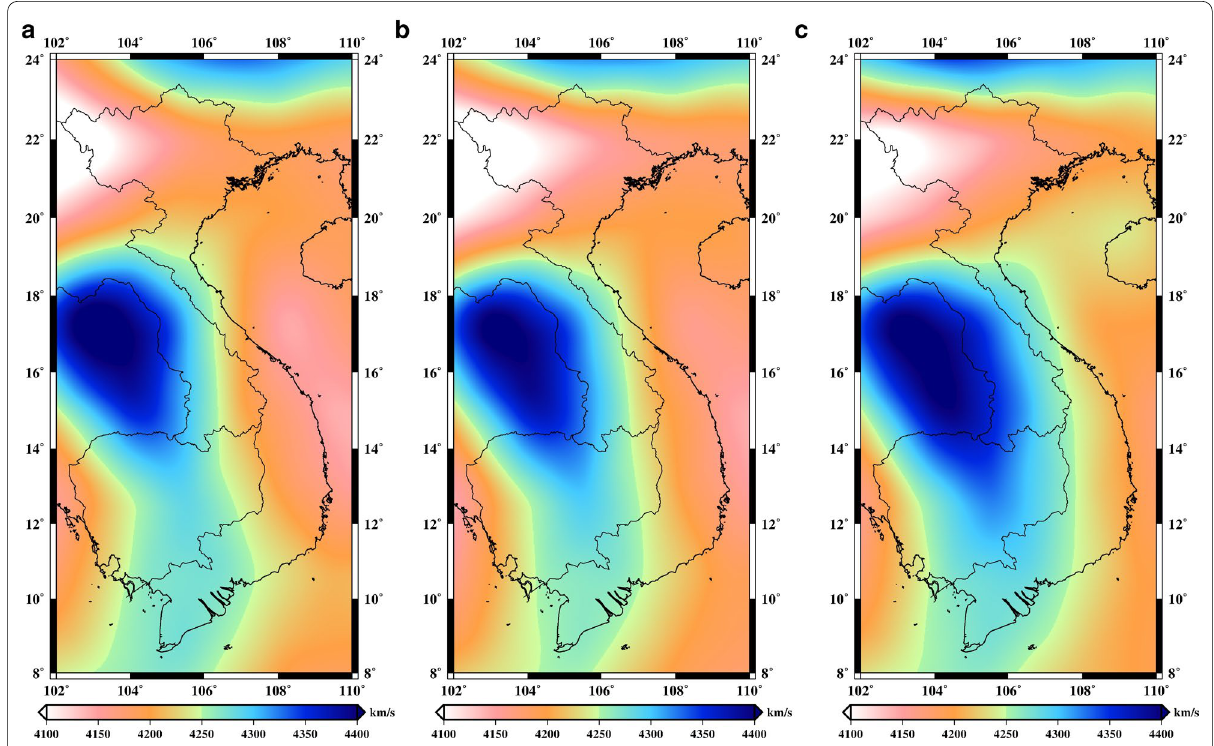
Fig. 13 Absolute S-wave velocity (V s ) derived from SL2013sv model at a 80 km, b 100 km, and c 125